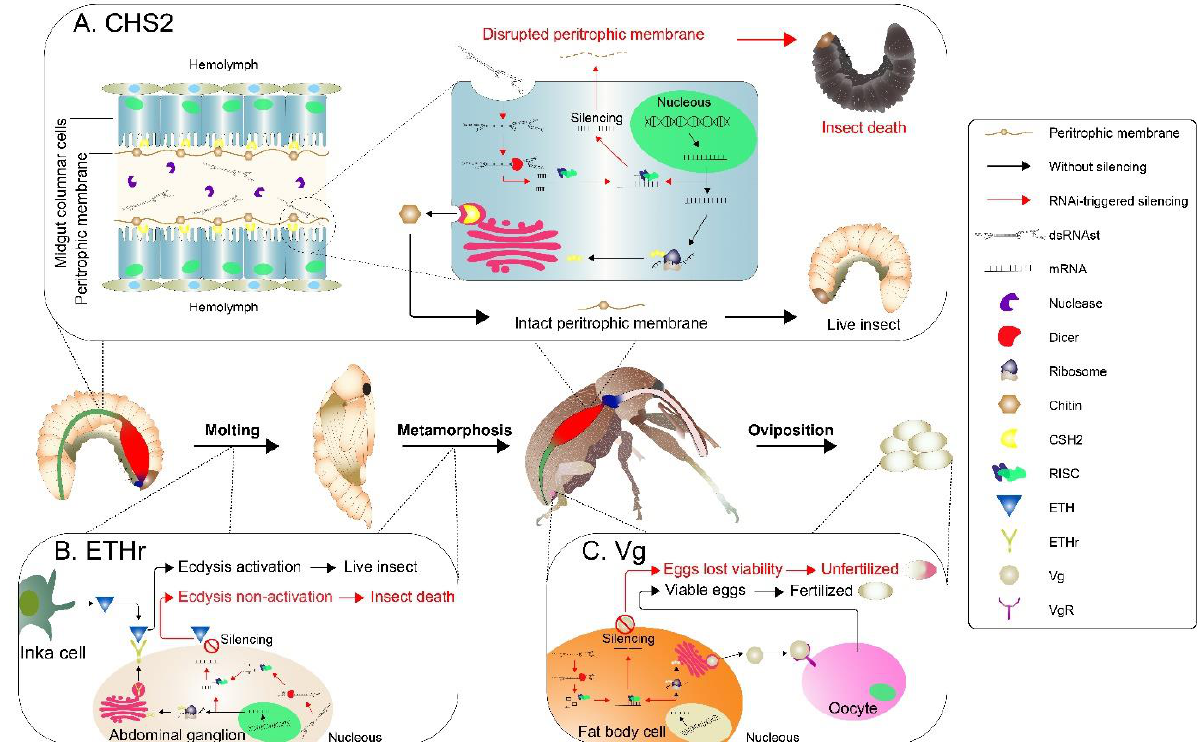
Figure 1. Schematic representation of the physiological and phenotypic effects of RNAi-mediated knockdown of chitin synthase II ( CHS2 ), vitellogenin ( Vg ), and Ecdysis-triggering hormone receptor ( ETHr ) in A. grandis . After feeding on transgenic cotton buds, the larva ingests structured dsRNA molecules (dsRNAst). The dsRNAst will be internalized by midgut columnar cells. Red arrows indicate the RNAi-mediated knockdown of target genes and its consequences on insect survival. In the presence of dsRNAst, DICER proteins convert dsRNA molecules into siRNA fragments that bind to the RNA-induced silencing complex (RISC) to degrade the target gene mRNA and, thus, prevent protein translation. Black arrows indicate the function and physiological cascades of the target genes with their endogenous gene expression (w/o RNAi). The A. grandis gut is